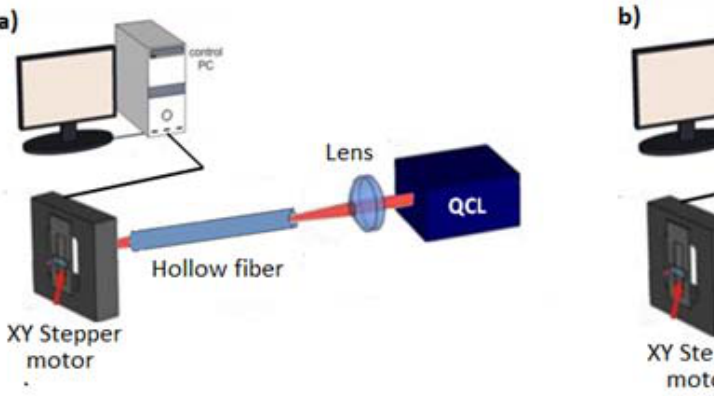
Figure 2. Schematics of the experimental setup. The laser beam is focused at the waveguide entrance using a ZnSe lens ( a ) or in a simple back-to-back configuration ( b ) and detected using a pyroelectric detector equipped with a XY stepper